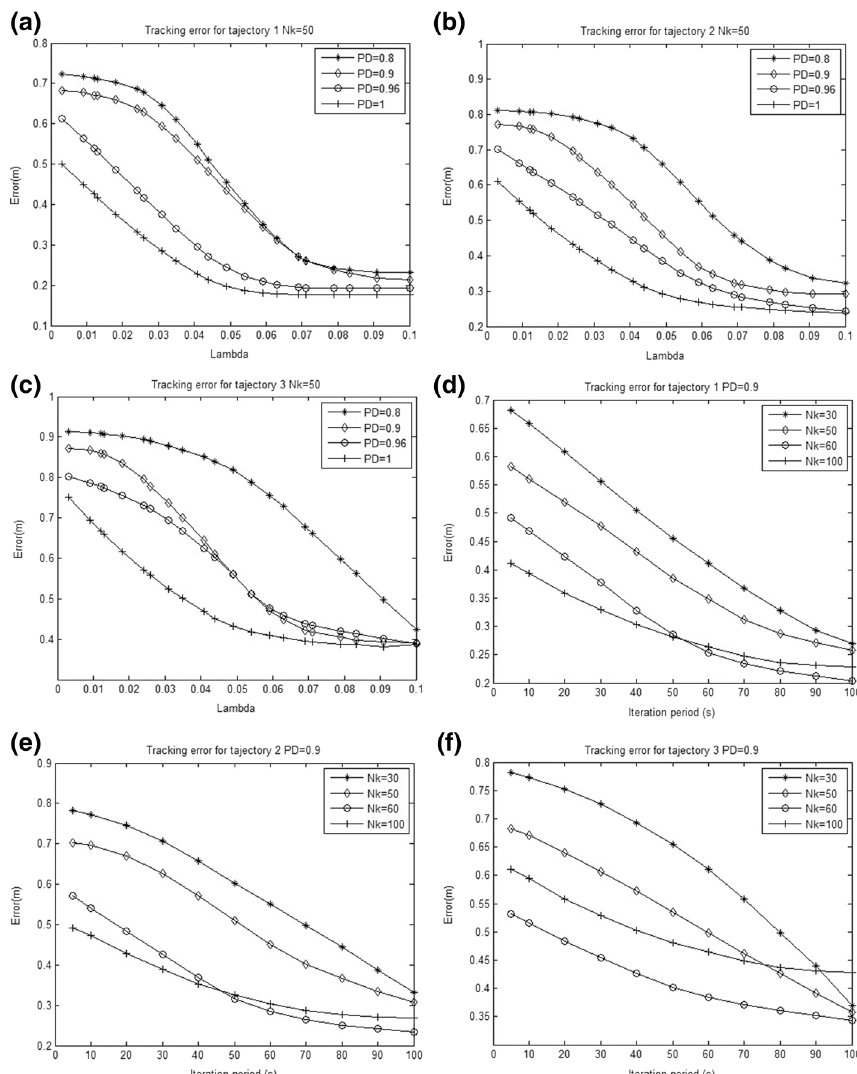
Fig. 4 a – c Tracking error related to detected probability p D based on node density (cid:31) 0 . a Trajectory 1; b Trajectory 2; c Trajectory 3; d – f Tracking error related to samples N k based on iteration periods. d Trajectory 1; e Trajectory 2; f Trajectory